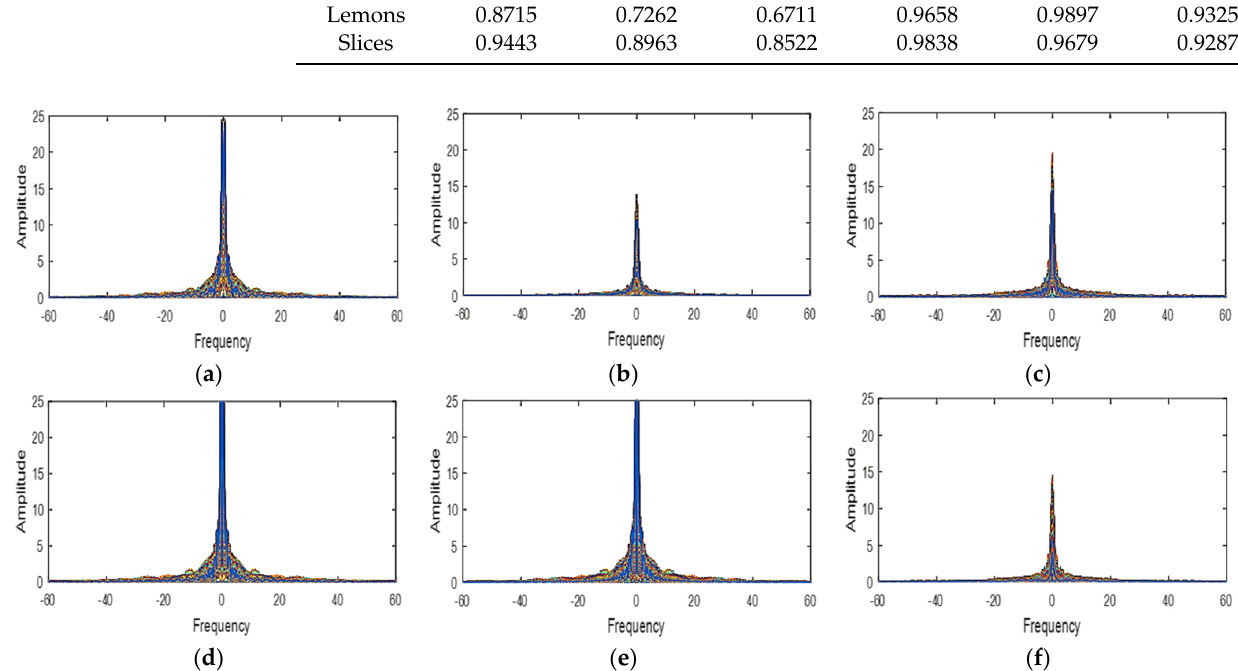
Figure 4. The power spectrum functions of the gradient signal in balloons image ( a ) green − red ( b ) green − blue ( c ) green–orange ( d ) red − blue ( e ) red − orange ( f ) blue − orange.